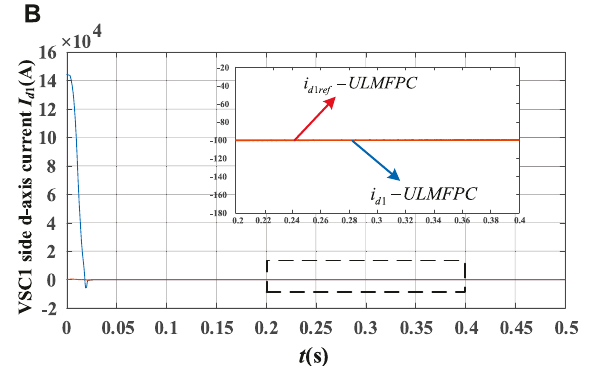
d1 of outer-loop PI method.